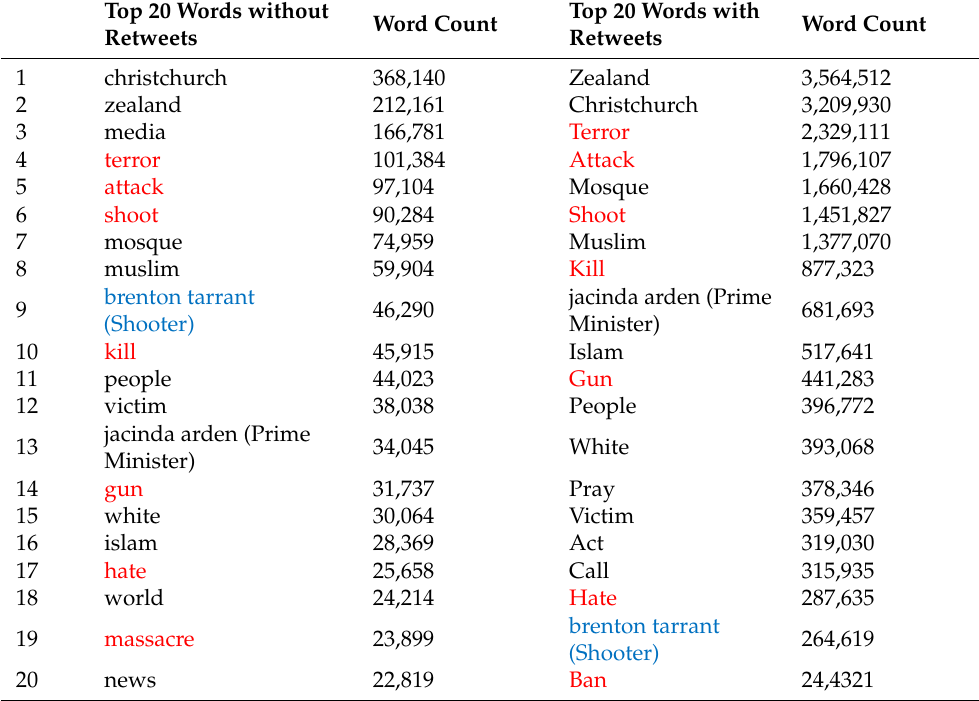
Table 7. Word Frequency for the Mosque